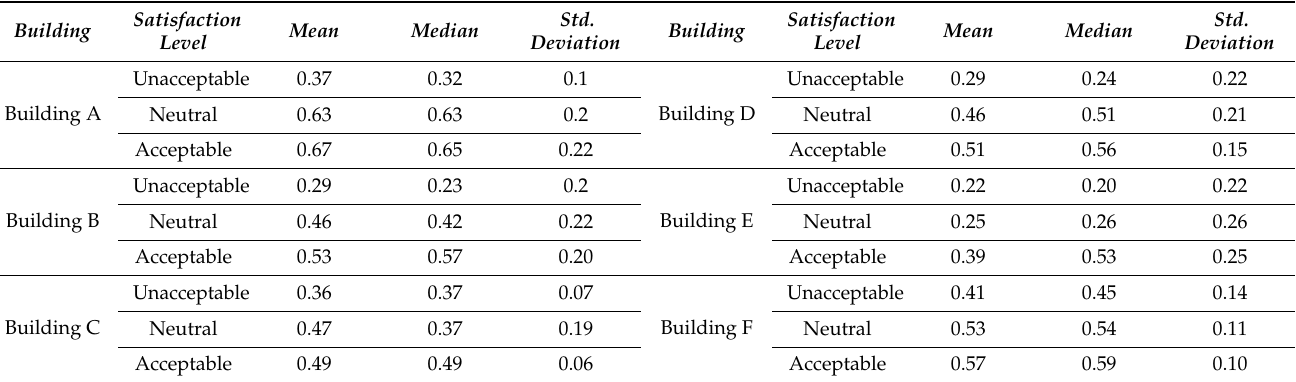
Table 5. Satisfaction level of DTR in the studied buildings.